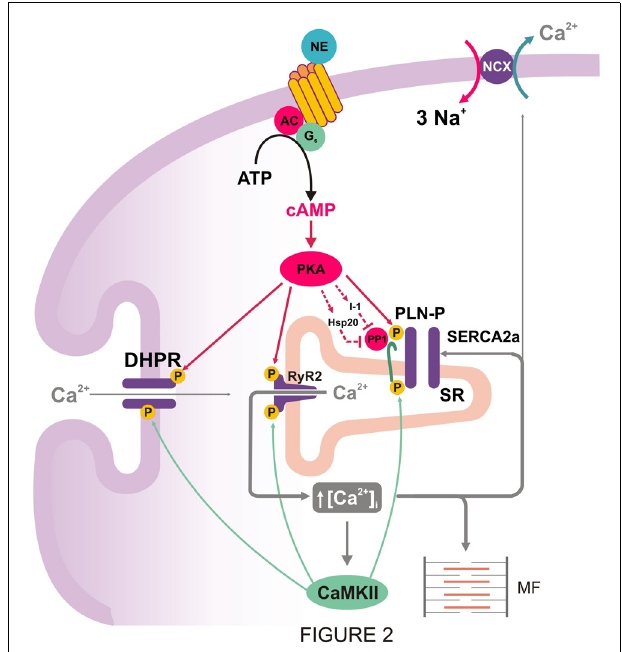
FIGURE 2 | PKA mediated increase in cytosolic Ca 2+ and inhibition of PP1: two prerequisites for CaMKII-dependent phosphorylation of PLN during β 1-adrenergic stimulation. PKA-dependent phosphorylation of Ca 2 + handling proteins, particularly L-type Ca 2 + channel and PLN, produces an increase in cytosolic Ca 2 + that is necessary to activate CaMKII and produce CaMKII-dependent phosphorylation. PKA also increases inhibitor-1 and Hsp20 phosphorylation, amplifying the stimulatory effects of β 1–adrenergic stimulation on SR Ca 2 + -transport, relaxation, and